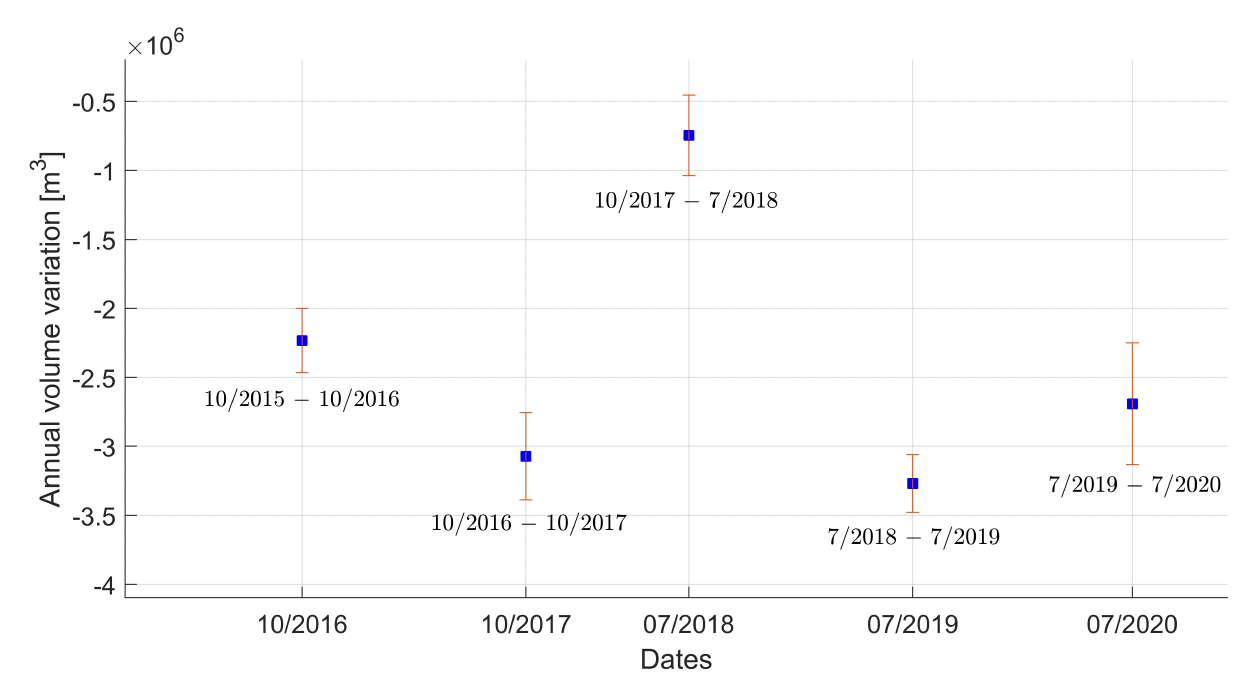
Figure 9. Yearly volume variation computed as difference between DSM of two consecutive years. The error bars plotted represent the uncertainty of each estimated value. Note that the values on the Y axis are expressed in million of m 3